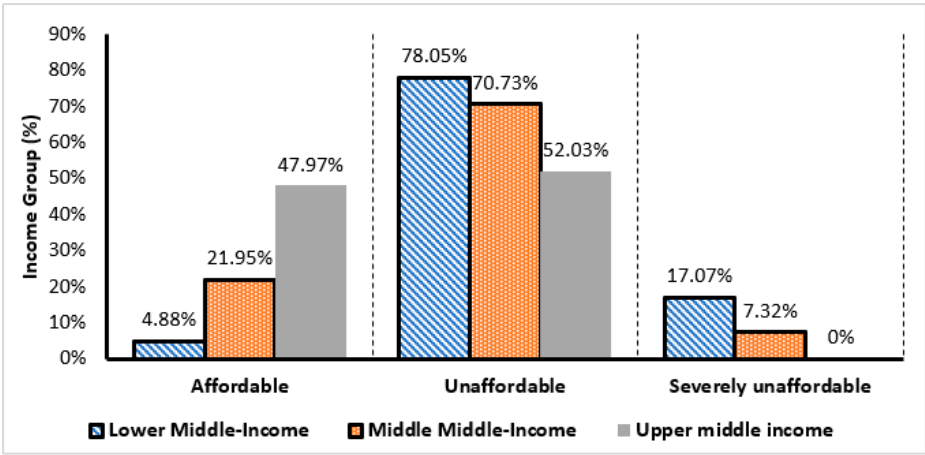
Figure 2. Affordability level of middle-income groups, Dhaka, Bangladesh. Source: [8,20,23]. The report entitled ‘State of Cities 2017: Housing in Dhaka’ published by BRAC Institute of Governance and Development (BIGD) stated that approximately 61 percent of homeowners from middle-income families depend on their personal or family savings to buy housing units in urban areas. Due to excessive house rents and apartment prices, lower-middle and middle-income families need to adjust their other daily expenditures to afford a dwelling unit. Seemingly, middle-income households reduce their clothing, entertainment, food, education and everyday expenses to cope with their excessive housing prices (Figure 3) [8].